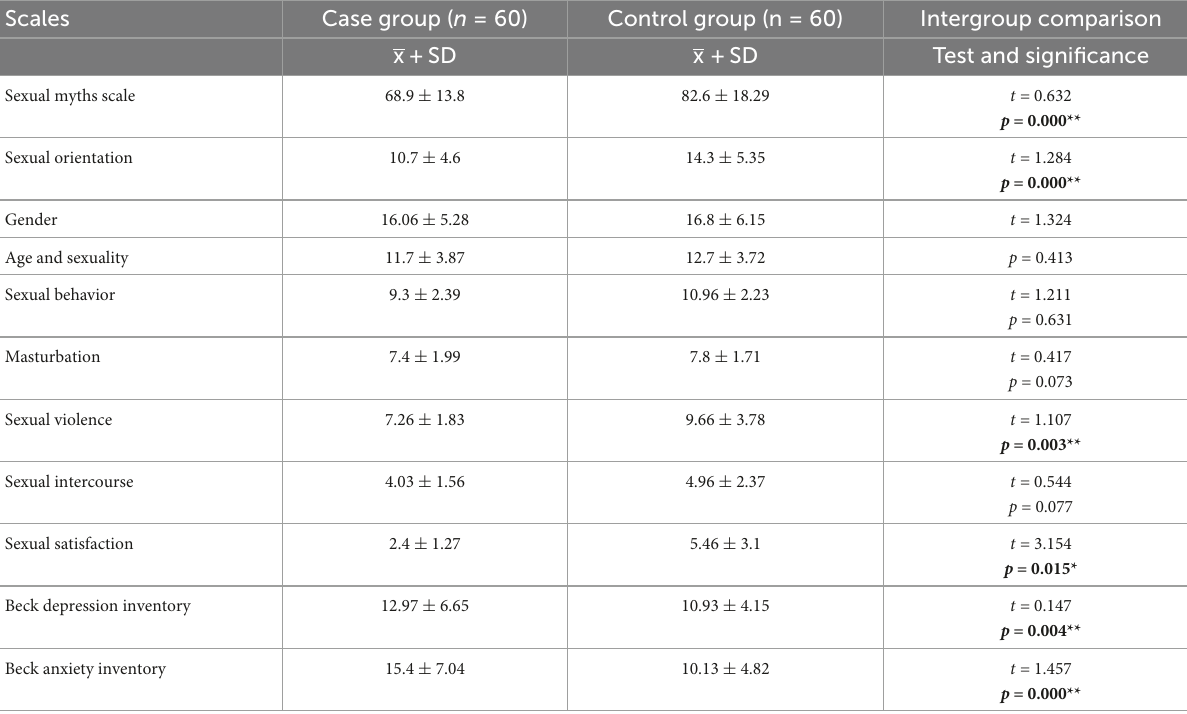
TABLE 3 Comparisons of levels of depression, anxiety, and believing sexual myths in case and control groups ( N = 120).